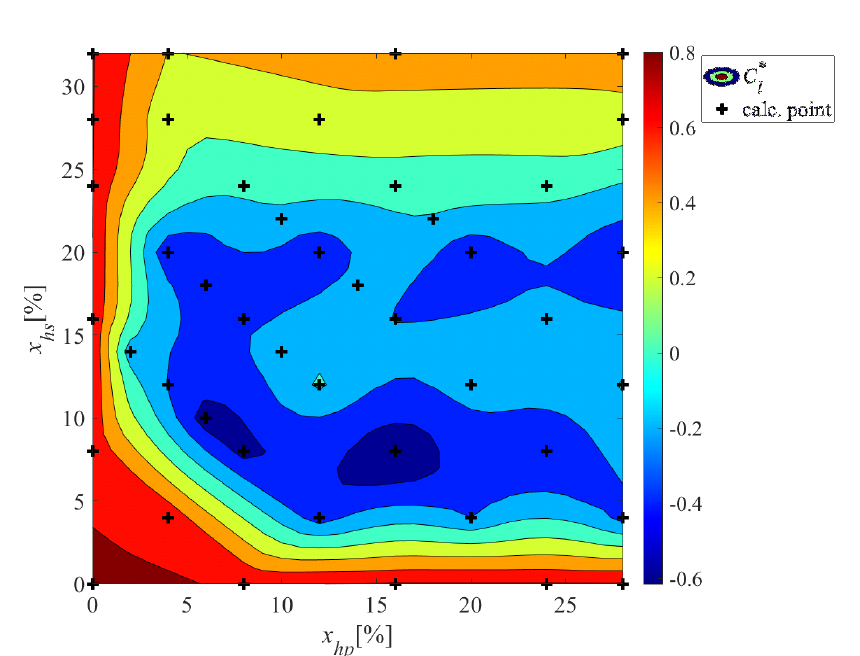
Figure 8. Lift coefficient change C ∗